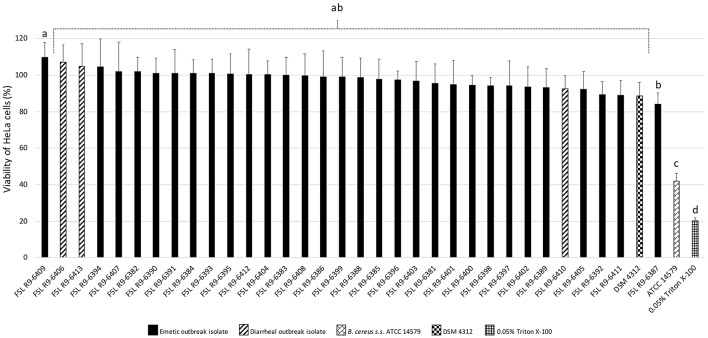
Percentage viability of HeLa cells when treated with supernatants of each isolate as determined by the WST-1 assay. Viability was calculated as ratio of corrected absorbance of solution when HeLa cells were treated with supernatants to the ratio of corrected absorbance of solution when HeLa cells were treated with BHI (i.e., negative control), converted to percentages. The columns represent the mean viabilities, while the error bars represent standard deviations for 12 technical replicates. Any two bars that do not share a common alphabetic character had significantly different percentage viability values (P < 0.05).